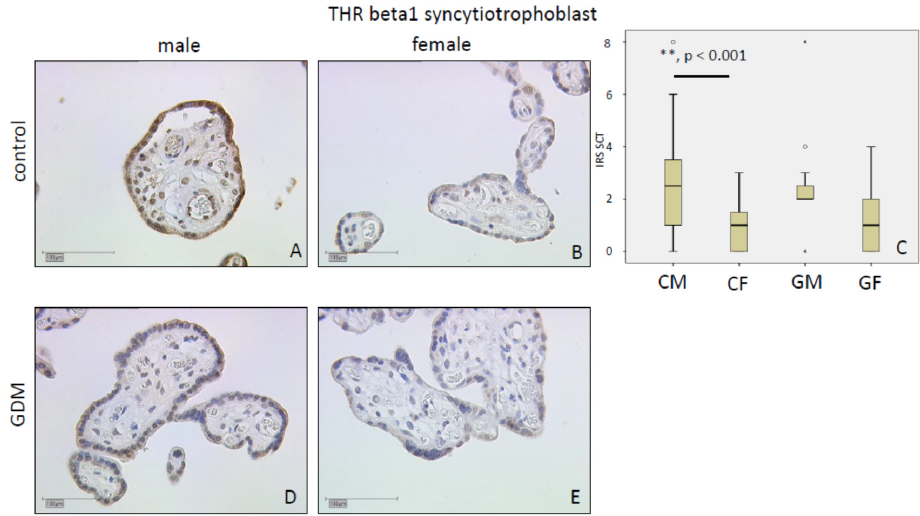
Figure 3. THR β 1 immunoreactivity is found with median intensity in SCT in controls ( A , B ) and in GDM ( D , E ). IRS for each group are shown as box plots for SCT (IRS SCT) ( C ). The boxes represent the range between the 25th and 75th percentiles with a horizontal line at the median. The circles indicate values more than one and a half box lengths, and the asterisk values more than three box lengths from the 75th percentile. Groups are labelled as follows: CM = control male; CF = control female; GM = GDM male; GF = GDM female. Scale bar = 100 µm.